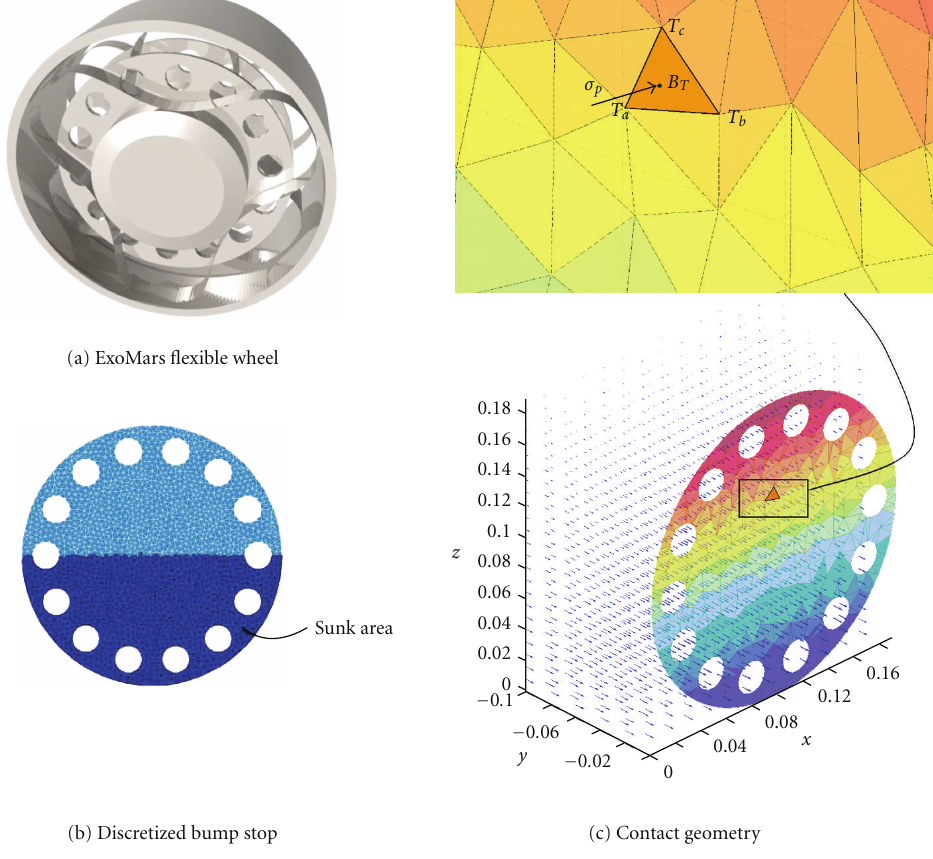
Figure 8: Lateral